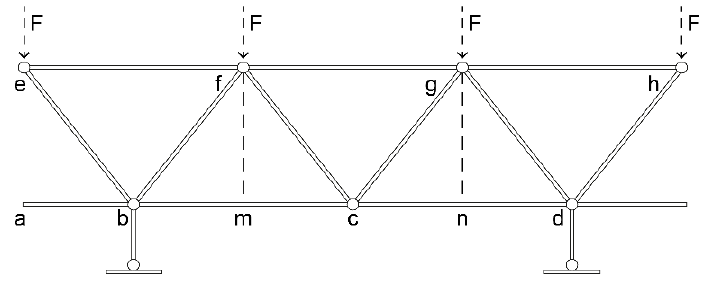
Figure 7. Force analysis of the Warren plane truss.